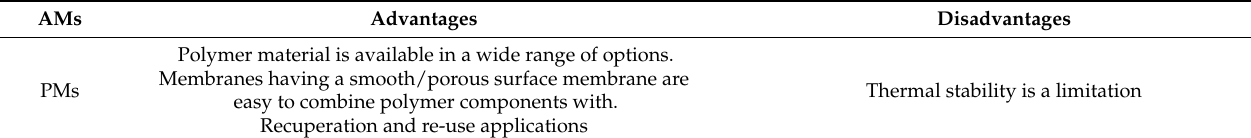
Figure 16. Depicts a scheme of several adsorptive membranes (AMs) used in heavy metal removal. ( a ) polymeric membranes (PMs) are made from polymer source materials, ( b ) polymer-ceramic membranes (PCMs) are made from a combination of polymeric and ceramic (natural clay materials: bentonite, kaolinite, and montmorillonite) materials, ( c ) electro-spinning nanofiber membranes (ENMs) are made from an electrospinning method for forming fibers with nanometer to micron diameters, and ( d ) nano-(carbonaceous materials, nanometal or nanometal oxides, and other organics) [199]. Table 10. Advantages and disadvantages of different AMs fabrication methods